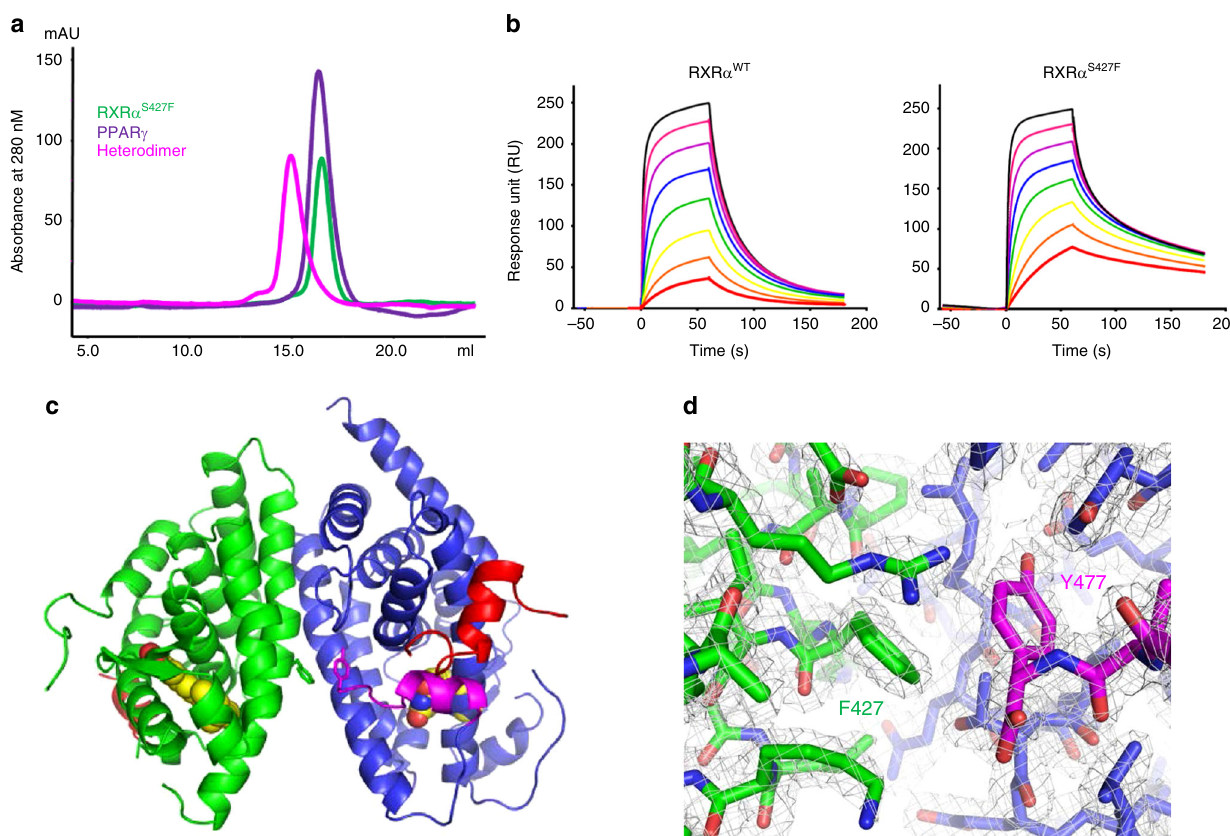
Fig. 2 S427F mutation in RXR α stabilizes heterodimerization with PPAR γ and promotes the agonistic conformation. a Sizing pro fi le of RXR α S427F mutant ( green ), PPAR γ ( purple ), and the heterodimer ( magenta ). Both RXR α S427F and PPAR γ run as monomers. When mixed together in 1:1 stoichiometry, the elution pro fi le shifts demonstrating formation of the heterodimer in the absence of ligand. b SPR demonstrating enhanced interaction between RXR α S427F mutant and PPAR γ . RXR α was immobilized to the CM5 chip by amine coupling and PPAR γ was injected in dose response from 3 μ M to 24 nM with 60 s association phase and 120 s disassociation. c Overall crystal structure of the heterodimer complex of RXR α S427F mutant ( green ) and PPAR γ ( blue ) with the co-activator peptide Src1 ( red ). The agonists 9-cis-retinoic acid and rosiglitazone are rendered as spheres. The AF-2 helix (Helix H12) of PPAR γ has been highlighted in magenta . RXR α S427 and PPAR γ Y477 are rendered as sticks and located in the dimer interface. d Zoom in of the heterodimer interface shows the S427F mutation of RXR α ( green ) introduces a π -stacking interaction with Y477 of PPARg ( blue ) at the C-terminus ( magenta ). The 2Fo – Fc electron density map is shown in gray and contoured at 1.2